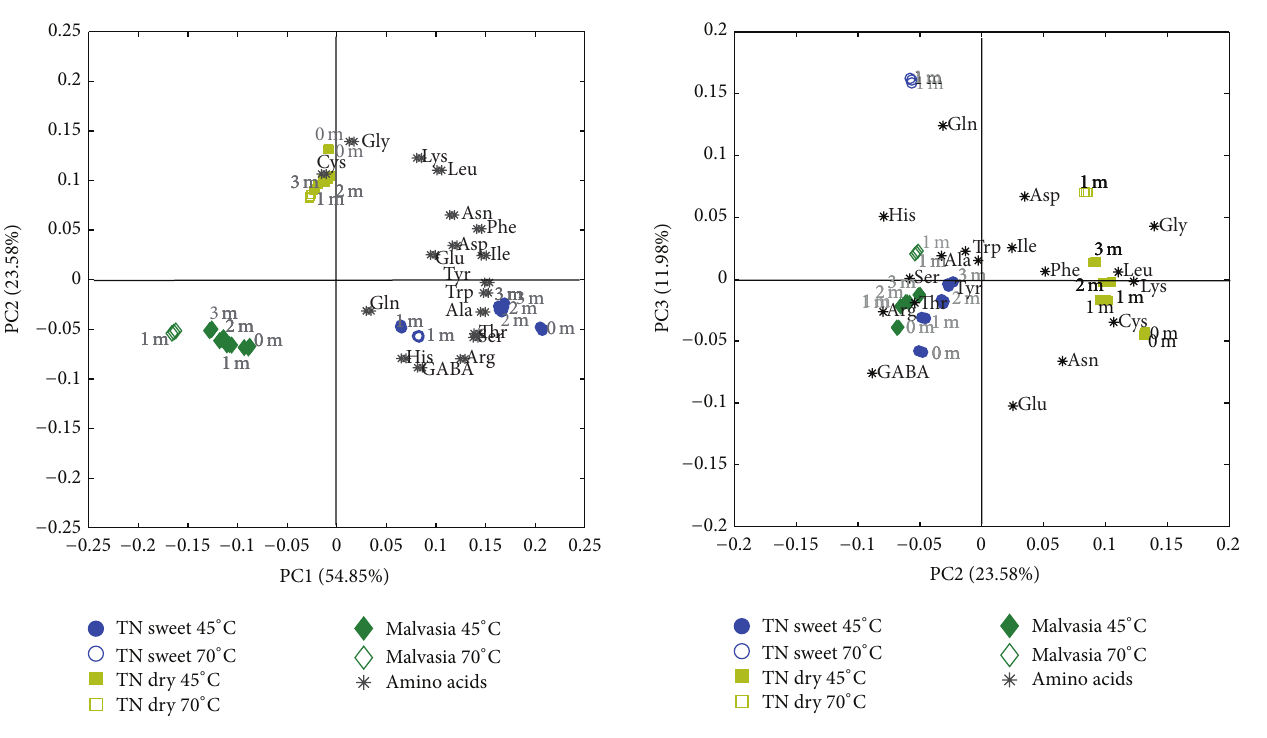
Figure 2: PC1 versus PC2 biplot of the Madeira wine samples sub- mitted to estufagem in order to visualize the different clusters.